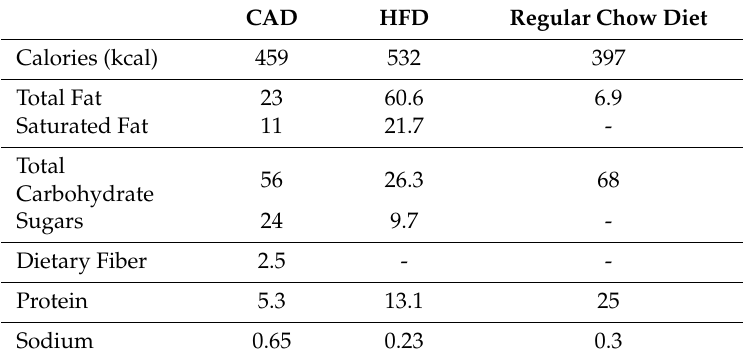
Table 1. Nutritional facts of the diets used. CAD